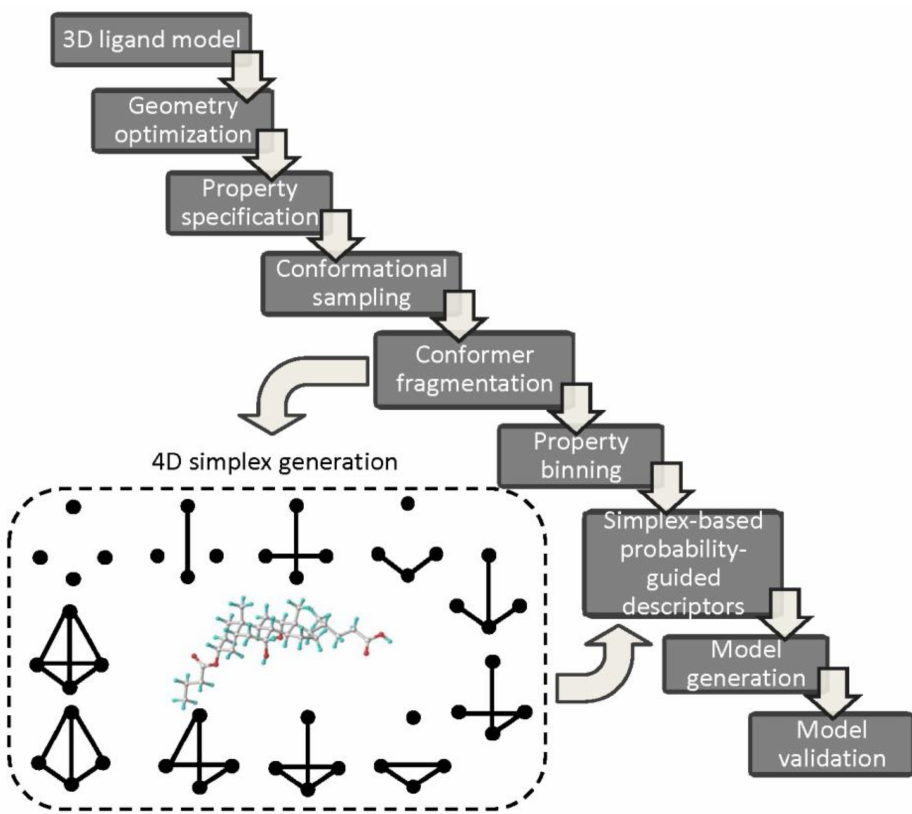
Figure 7. SiRMS protocol